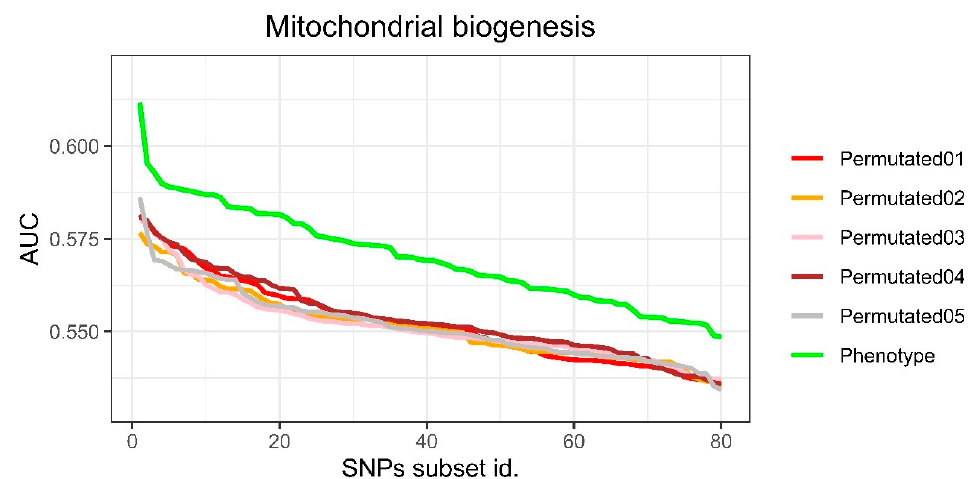
Figure 7. AUC values of the 80 iterations performed for the mitochondrial biogenesis pathway in the case of cases and controls (phenotype) and five different permutations.